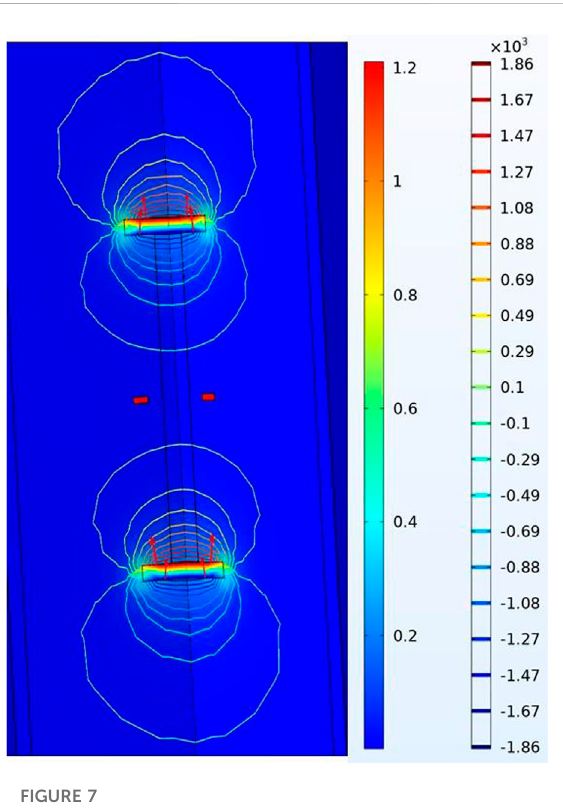
FIGURE 7 Simulated magnetic fl ux density of the working unit. [unit